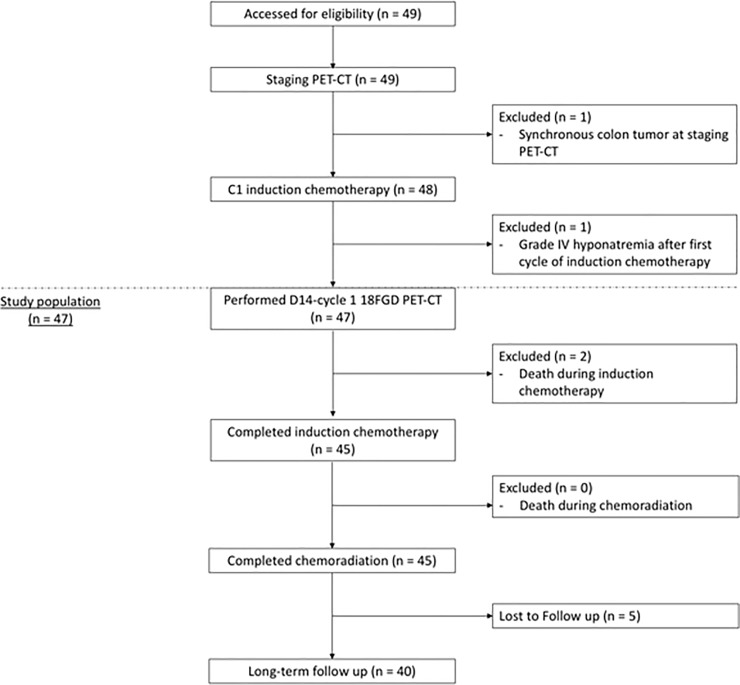
The Consort flowchart descriptions of the entire study populations.